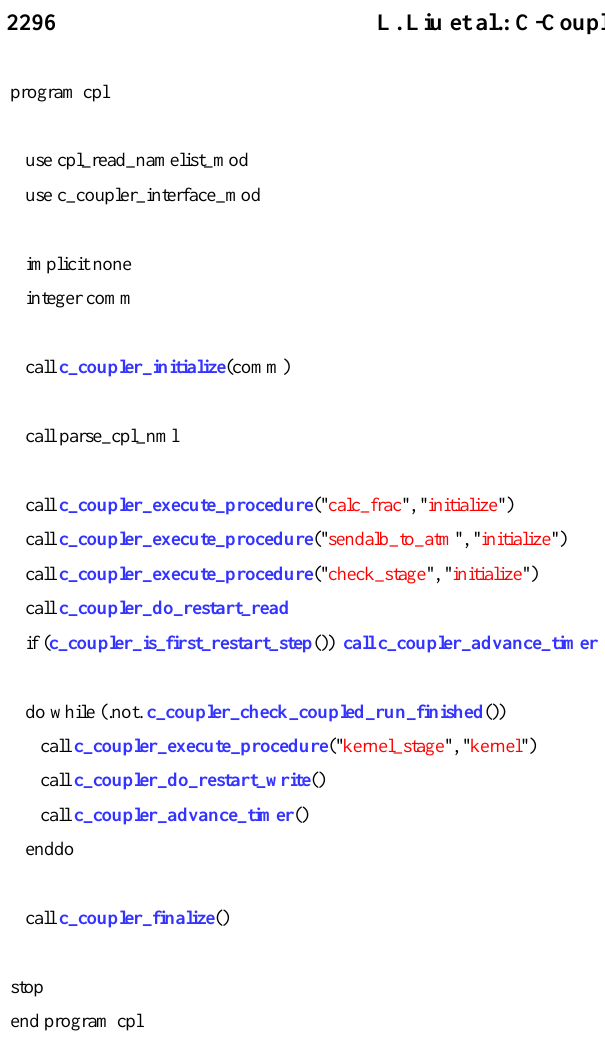
Figure 6. The code of the main driver of the coupler component in Fig. 4. The code of the main driver of the coupler component in the FGOALS-gc. The C-2 FGOALS-gc. The C-Coupler APIs are marked in blue. Coupler APIs are marked in blue. 3